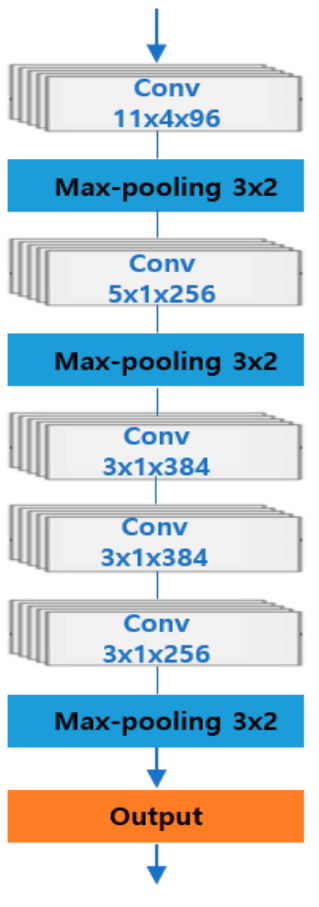
Figure 5. Structure of an FCNN encoder.